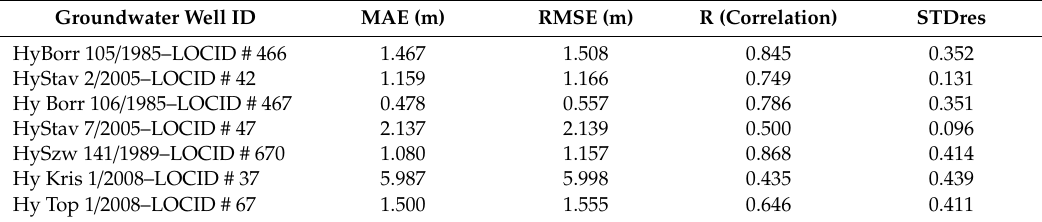
Table 6. Statistics of the objective function for groundwater level calibration.